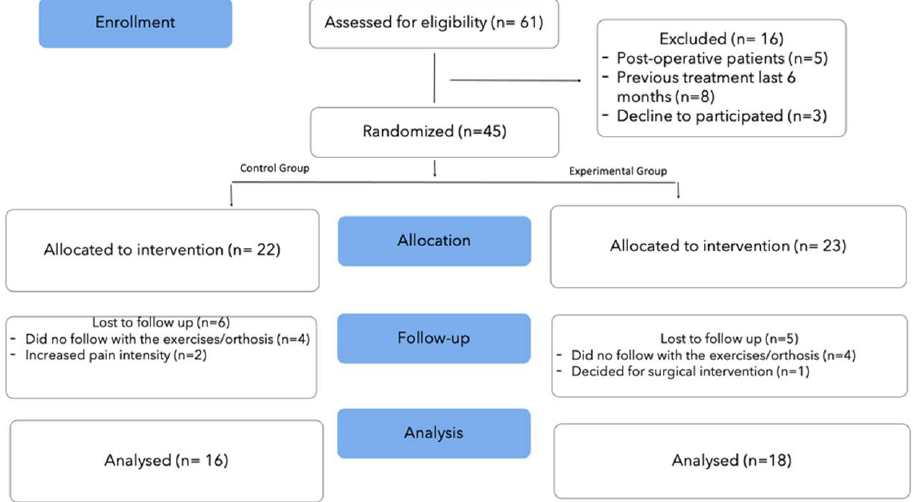
Figure 3. Flow chart of the study . Table 1. Characteristics of patients at baseline.